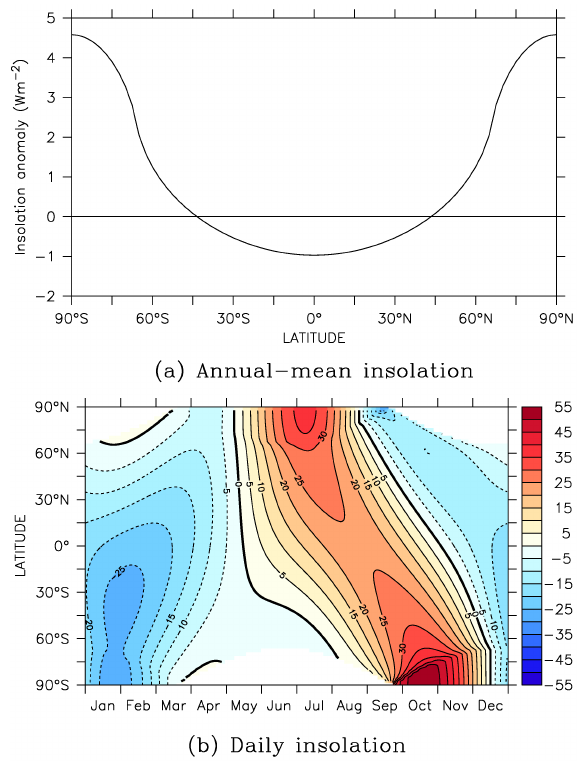
Fig. 1. The insolation (Wm − 2 ) at 6000yrBP, expressed as an anomaly relative to the present day: (a) the annual mean, and (b) daily